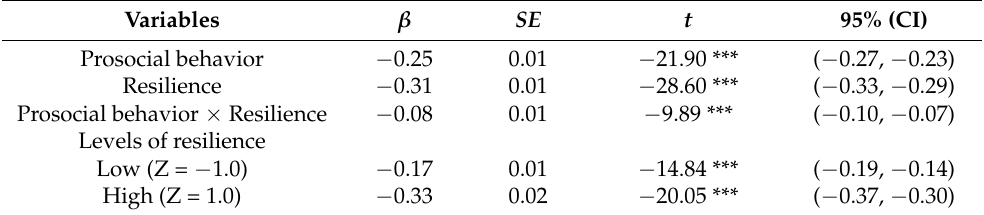
Table 3. Moderating effect of resilience on the associations between prosocial behavior and depres- sion. Variables β SE